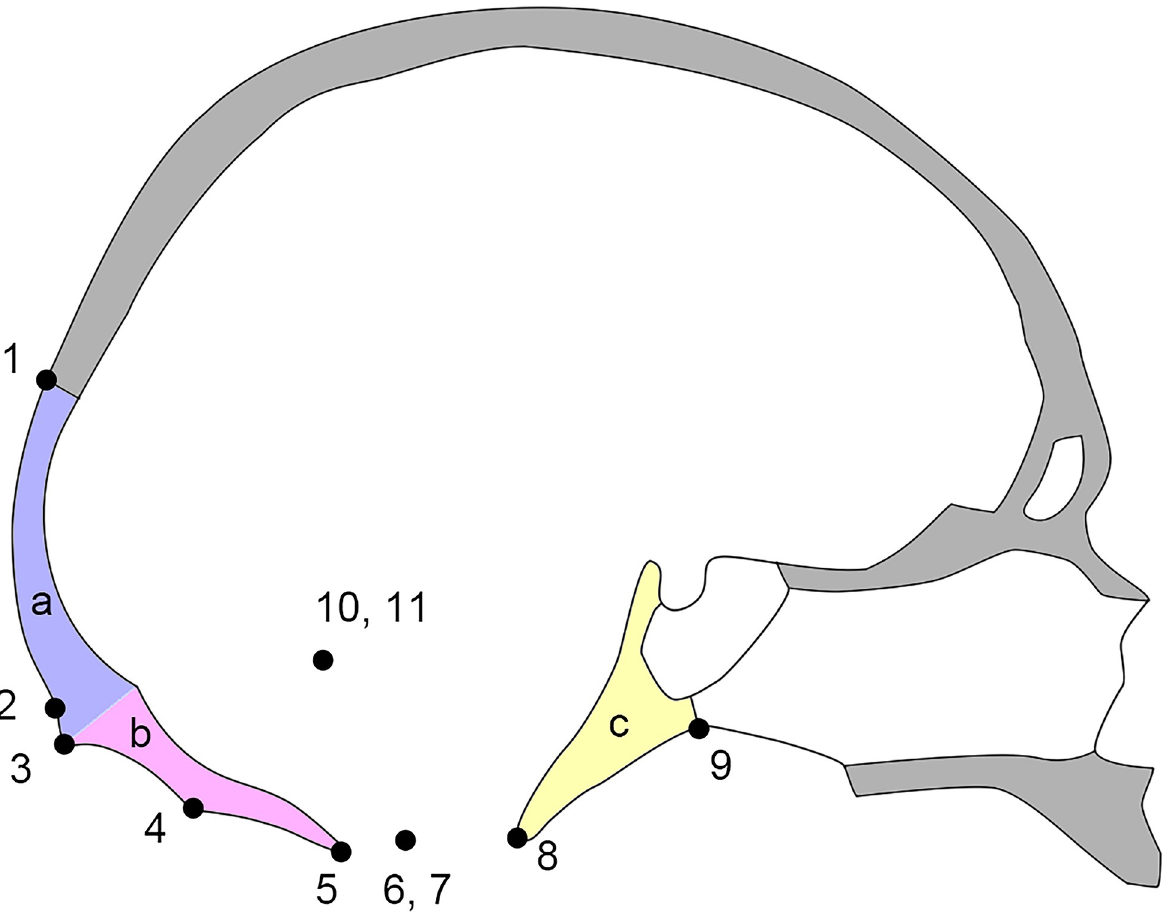
Fig 1. Diagram of occipital landmarks and occipital components in sagittal profile. 1. Lambda, 2. Suprainion, 3. Inion, 4. Intersection of the inferior nuchal line and external occipital crest, 5. Opisthion, 6, 7. Left and right occipital postcondylar point, 8. Basion, 9. Hormion, 10, 11. Left and right asterion, a. Occipital plane, b. Nuchal plane, c. Occipital